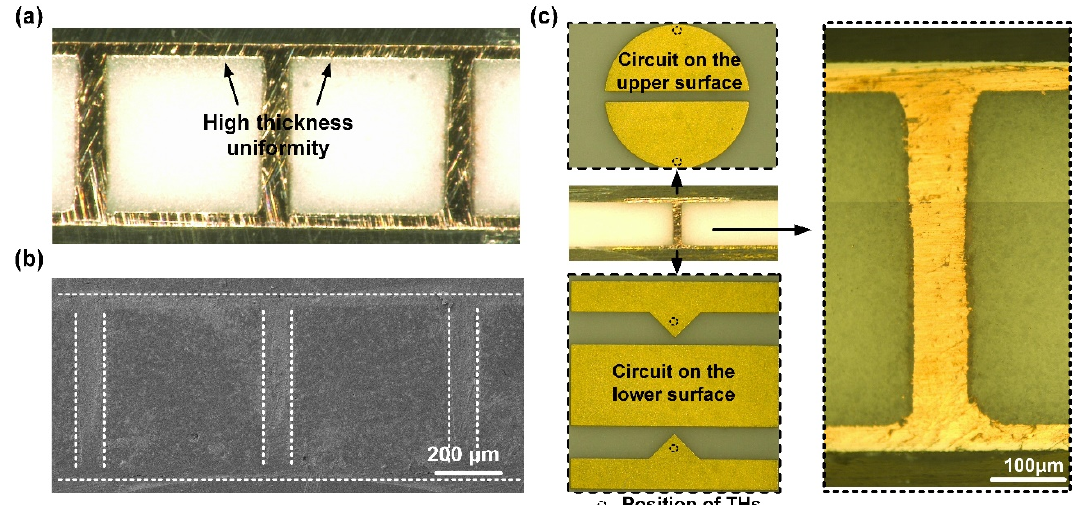
Figure 7. Cross-sections of THs. ( a ) Optical microscope images of THs array, ( b ) SEM images of THs array, and ( c ) optical microscope images of the interconnected substrate.